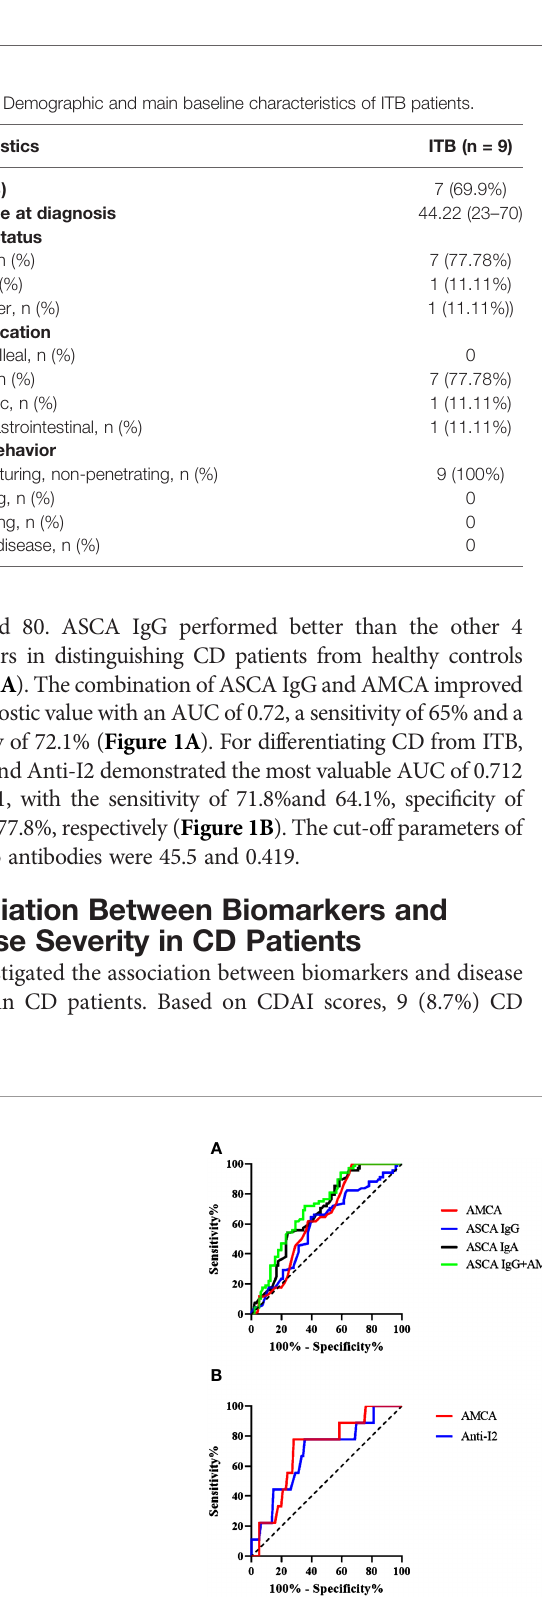
FIGURE 1 | (A) Receiver-operating characteristics (ROC) analysis of the discrimination power of ASCA (IgA and IgG), AMCA and ASCA IgG combined with AMCA in patients with CD (n = 103) and healthy control (n = 68); (B) ROC analysis of the discrimination power AMCA and Anti-12 in patients. (C) ROC analysis of the discrimination power of Anti-I2 in patients with CD-ITB (n=10) and ITB